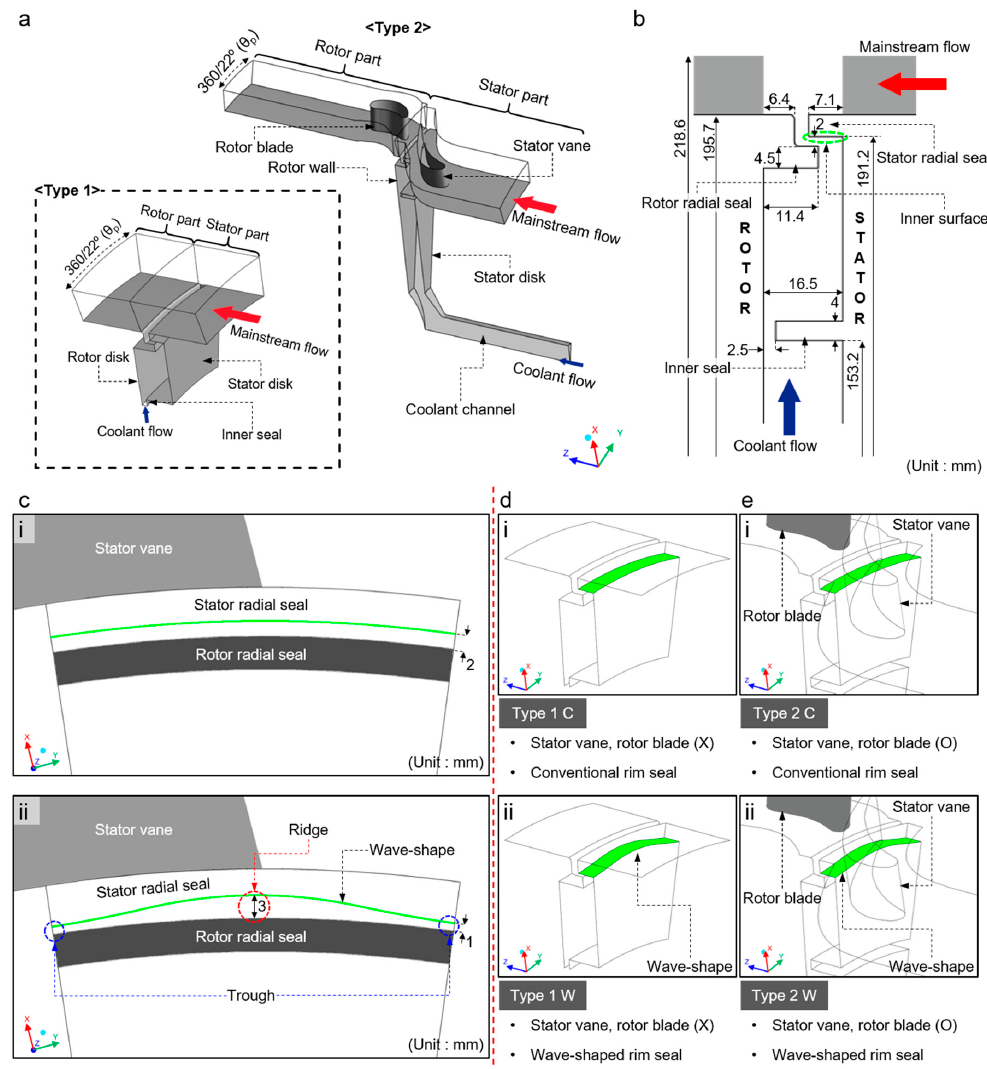
Figure 2. Schematics of geometries: ( a ) Computational domain of Type 1 and Type 2; ( b ) Dimensions of wheelspace; ( c ) front view of wheelspace; ( i ) the conventional rim seal and ( ii ) the wave-shaped rim seal; ( d ) inner surface of stator radial seal (green surface) of Type 1; ( i ) conventional rim seal and ( ii ) wave-shaped rim seal; ( e ) inner surface of stator radial seal (green surface) of Type 2; ( i ) conventional rim seal and ( ii ) wave-shaped rim seal.